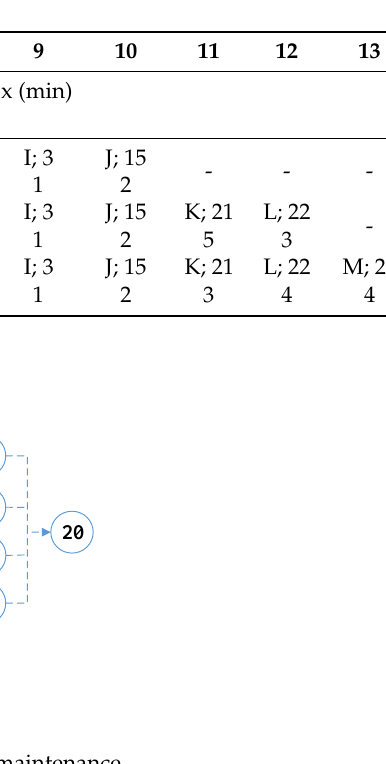
Figure 10. Process AoN diagram for preventive maintenance.